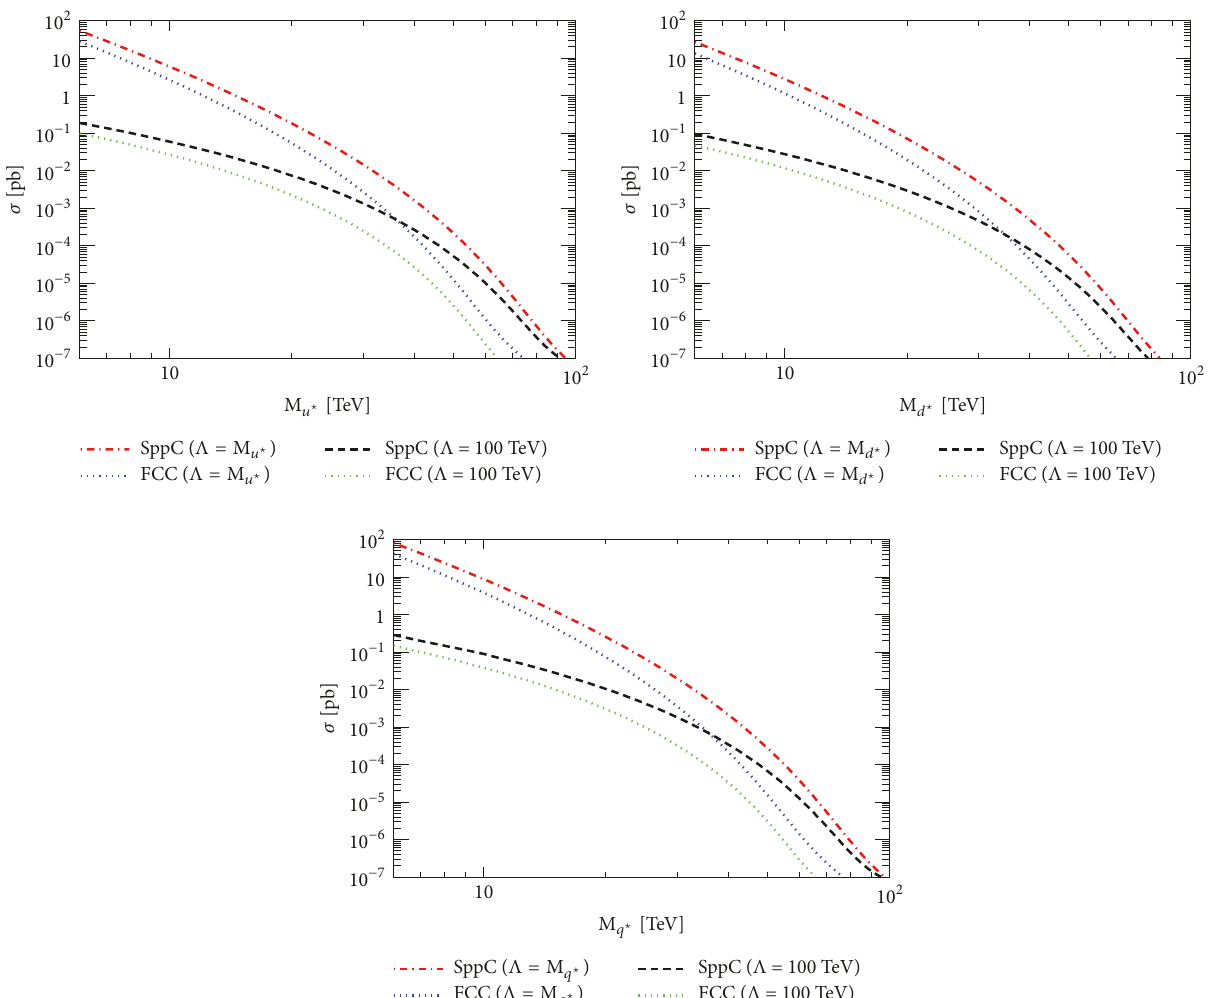
Figure 3: Cross section values of the first generation 𝑢 ⋆ , 𝑑 ⋆ , and 𝑞 ⋆ (degenerate state) excited quarks at the FCC and